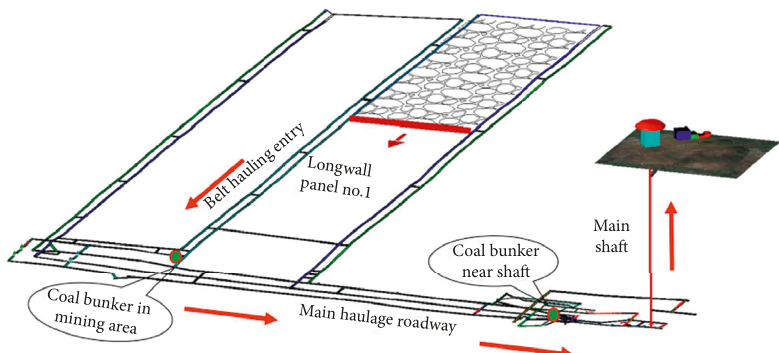
Figure 1: Coal transportation system in an underground coal mine.